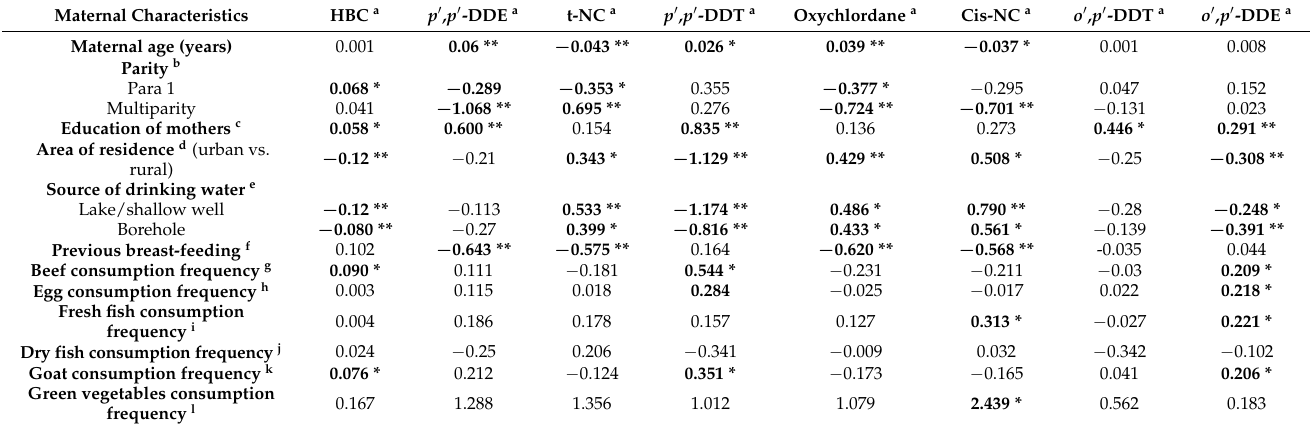
Table 2. Univariate linear regression of POP concentrations in blood serum and maternal characteristics.